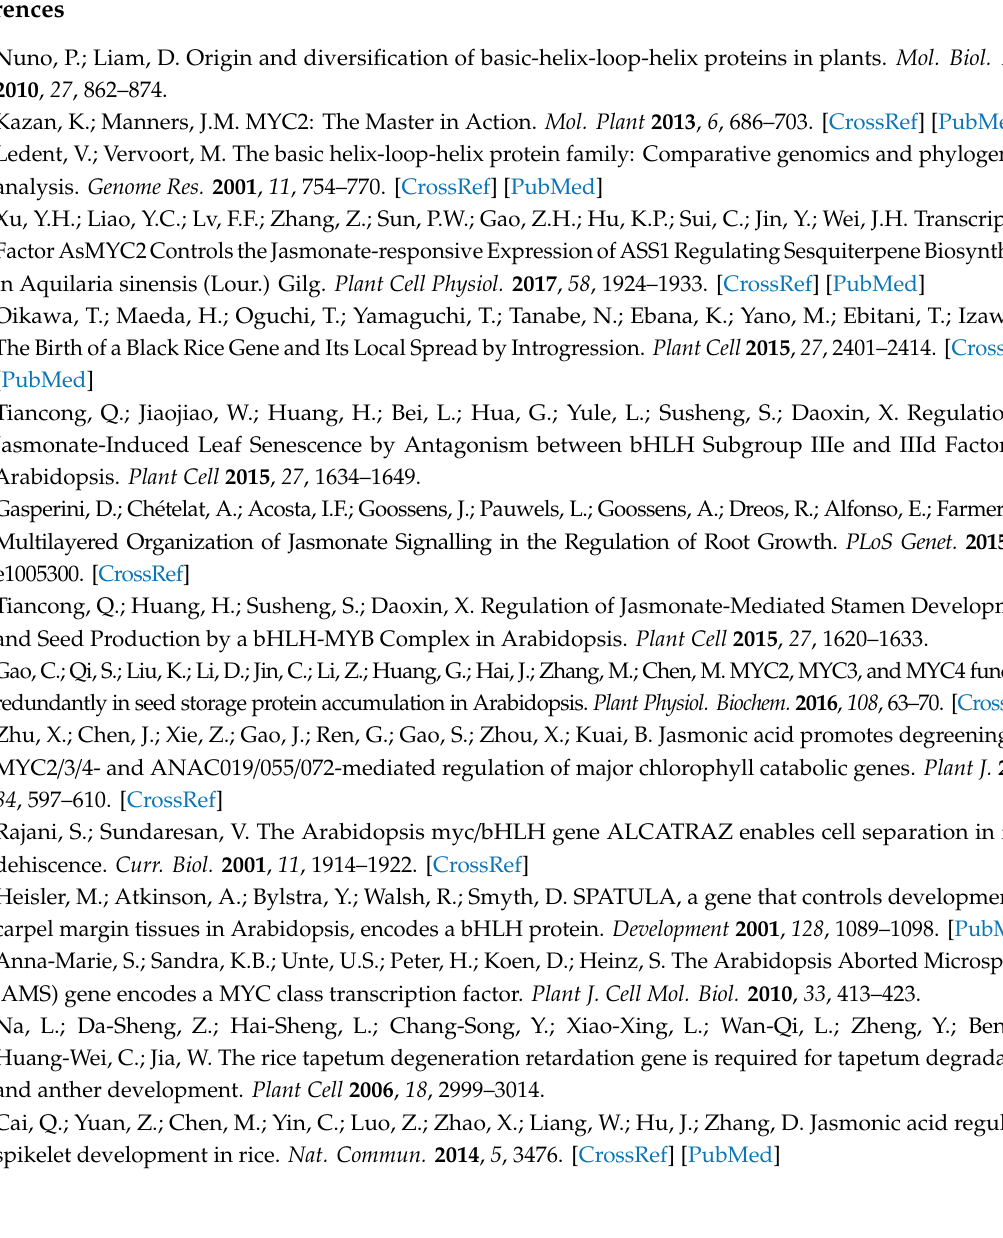
Figure S1: The JAZ interaction domain (JID), putative transcriptional activation domain (TAD) were identified in the MYC proteins; Figure S2: The bHLH domain and leucine zipper domain were identified in the MYC proteins; Table S1: The detailed information of TaMYCs , OsMYCs , BdMYCs ; Table S2: The consensus ratio of the conserved amino acid residues in the bHLH_MYC_N domains, Table S3: The consensus ratio of the conserved amino acid residues in the bHLH domains of TaMYCs , OsMYCs , and BdMYCs , Table S4: Wheat, rice, and B. distachyon MYC gene duplication events, Table S5: The homologous genes between plant MYC genes, Table S6: Primer used in this